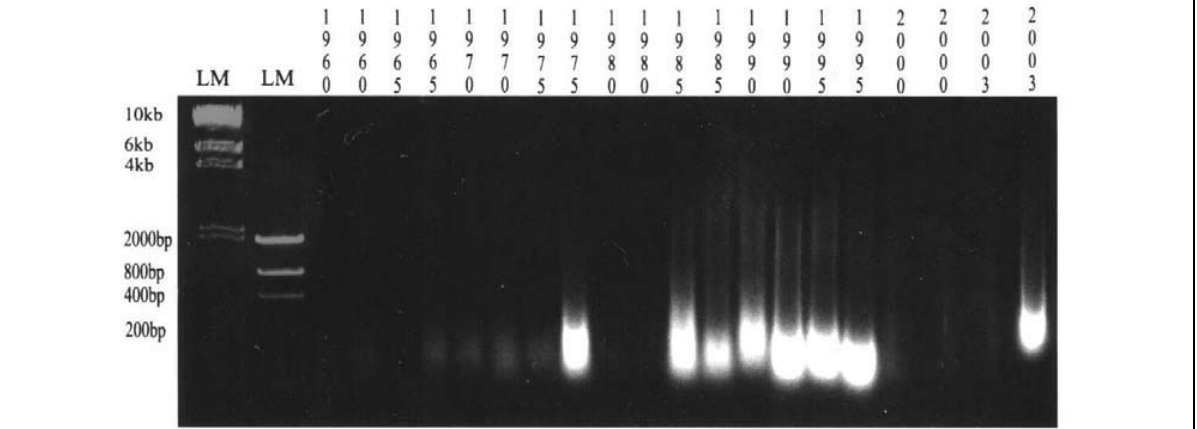
Figure 2 – Electrophoresis gel of genomic DNA extracted from archival tissue from different storage time (xylene-phenol-chroform technique; original magnification) LM: low mass.